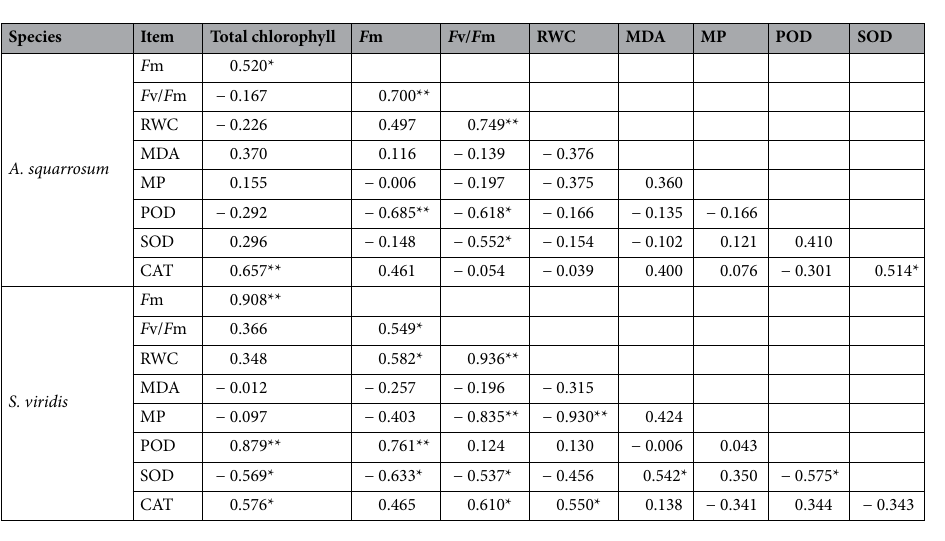
Table 1. Values of Pearson’s correlation coefficient ( r ) for the relationships among the physiological characteristics for all drought durations, including values after rehydration, in A. squarrosum and